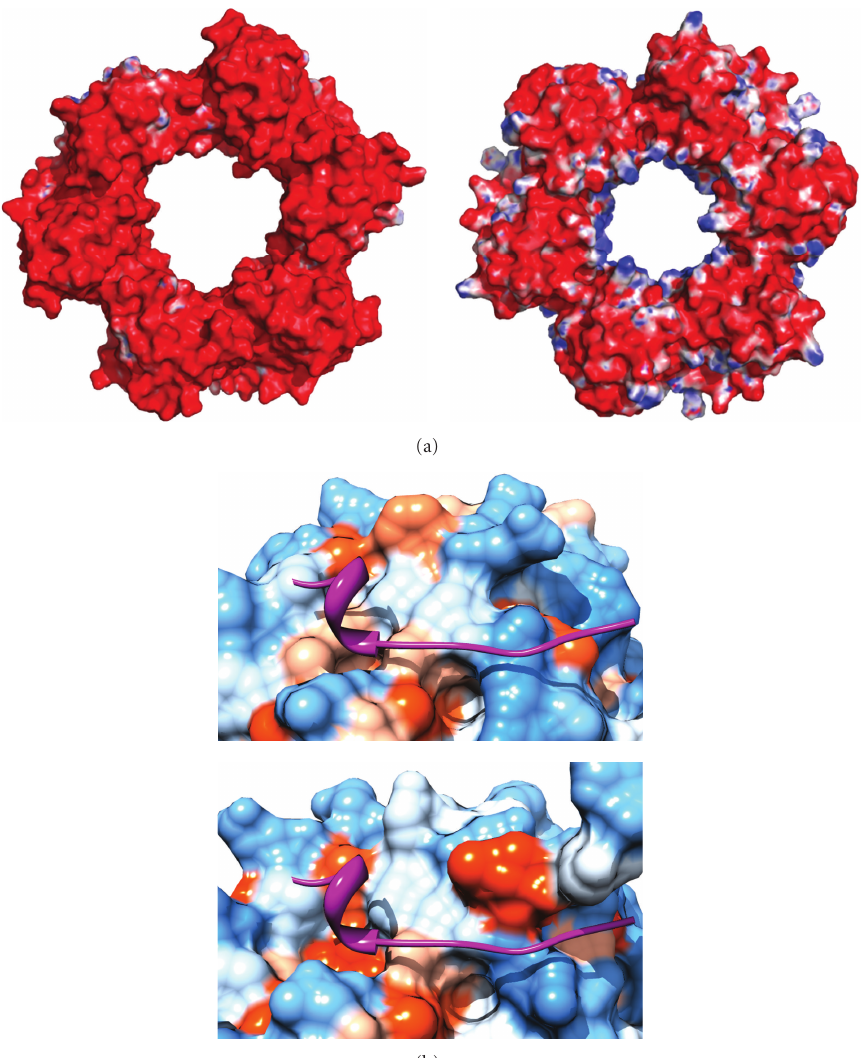
Figure 7: Adaptation to the high salt environment of HvoPCNA [20]. (a) Electrostatic surface representation of HvoPCNA (left—3IFV) and the more typical AfuPCNA (right—1RWZ), with the surface coloured from − 10 k B T/e (red) to +10 k B T/e (blue), showing loss of the electropositive charge from the central pore of PCNA are calculated using APBS [30]. (b) The HvoPCNA binding pocket (top) shows a reduction in hydrophobic character and in depth of the binding pocket compared to AfuPCNA (bottom). The surfaces are coloured according to the Kyte-Doolittle scale with blue indicating the most hydrophilic residues through to orange for the most hydrophobic residues. The AfuFen1 peptide of 1RXZ is shown in magenta in both panels for comparison. Produced using Chimera